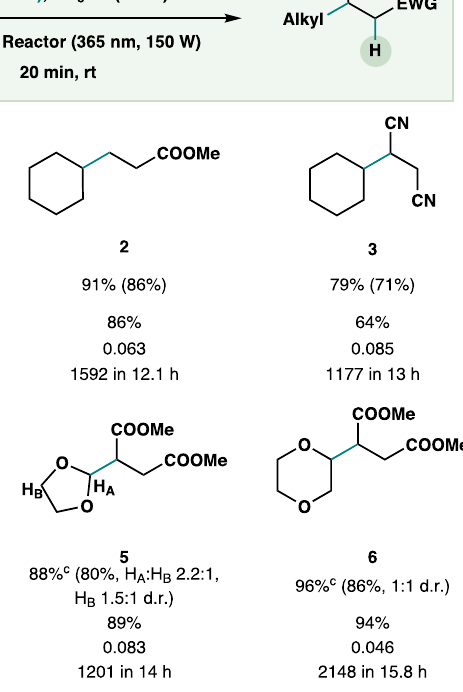
Information for additional details). Isolated yields are given in parentheses. b The yield was determined by 1 H-NMR using 1,2,4,5-tetramethylbenzene as external standard. c 1.2mol%